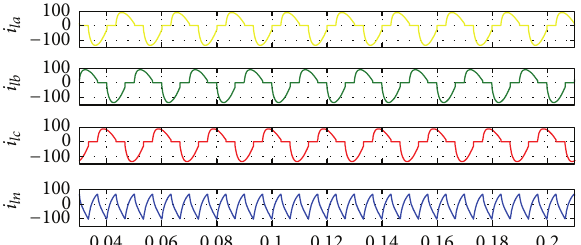
Figure 8: The load current waveforms before compensation.